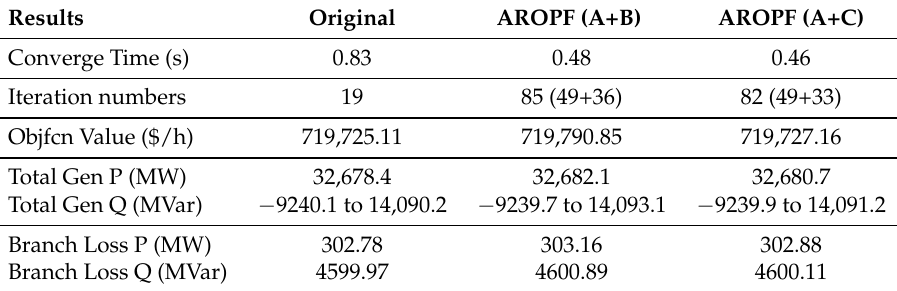
Table 5. Case 300 time cost and optimization